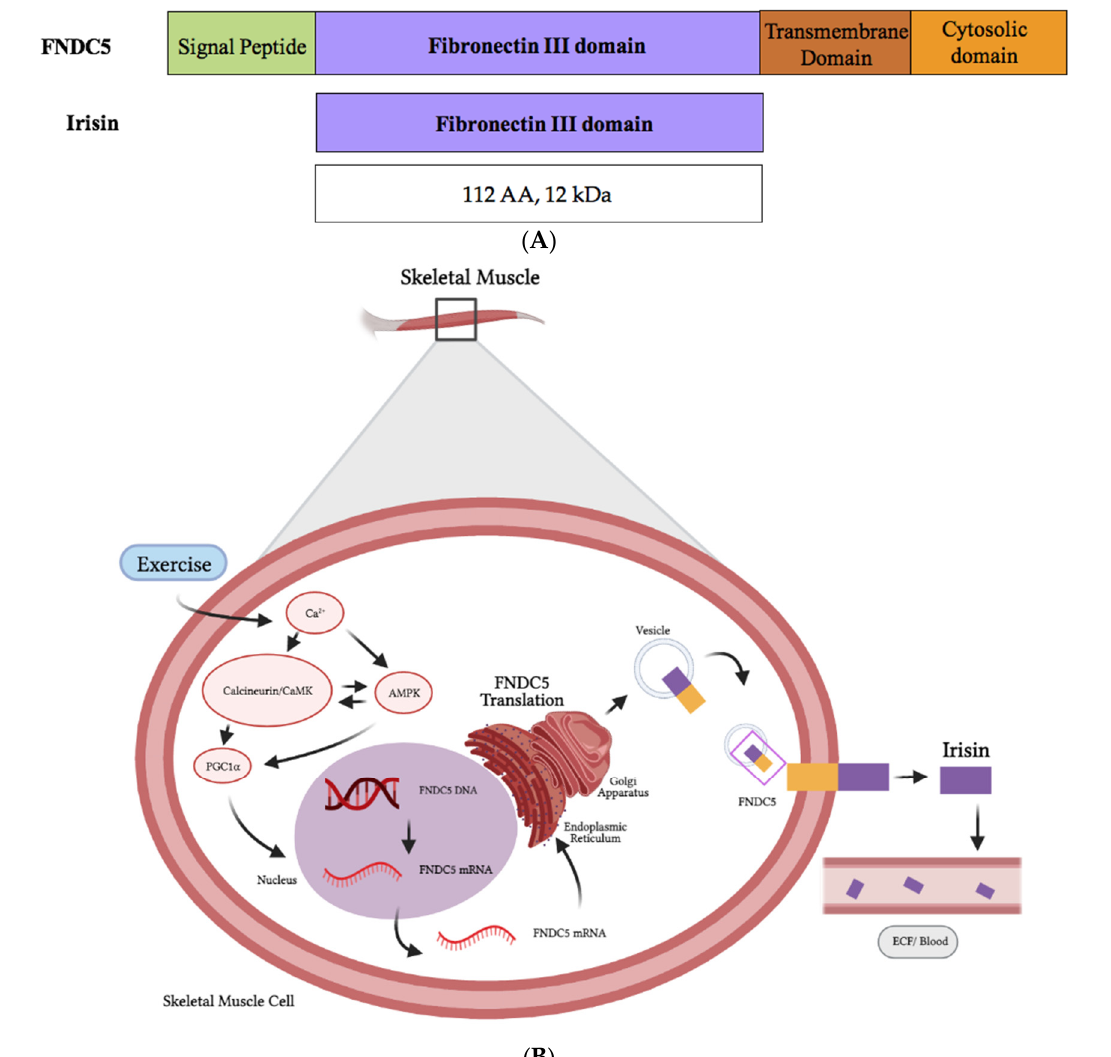
Figure 2. Schematic representation of FNDC5 and the irisin protein domains ( A ). The synthesis and release of irisin by muscle cells is induced by exercise ( B ). Figure 2B was created with BioRender.com.